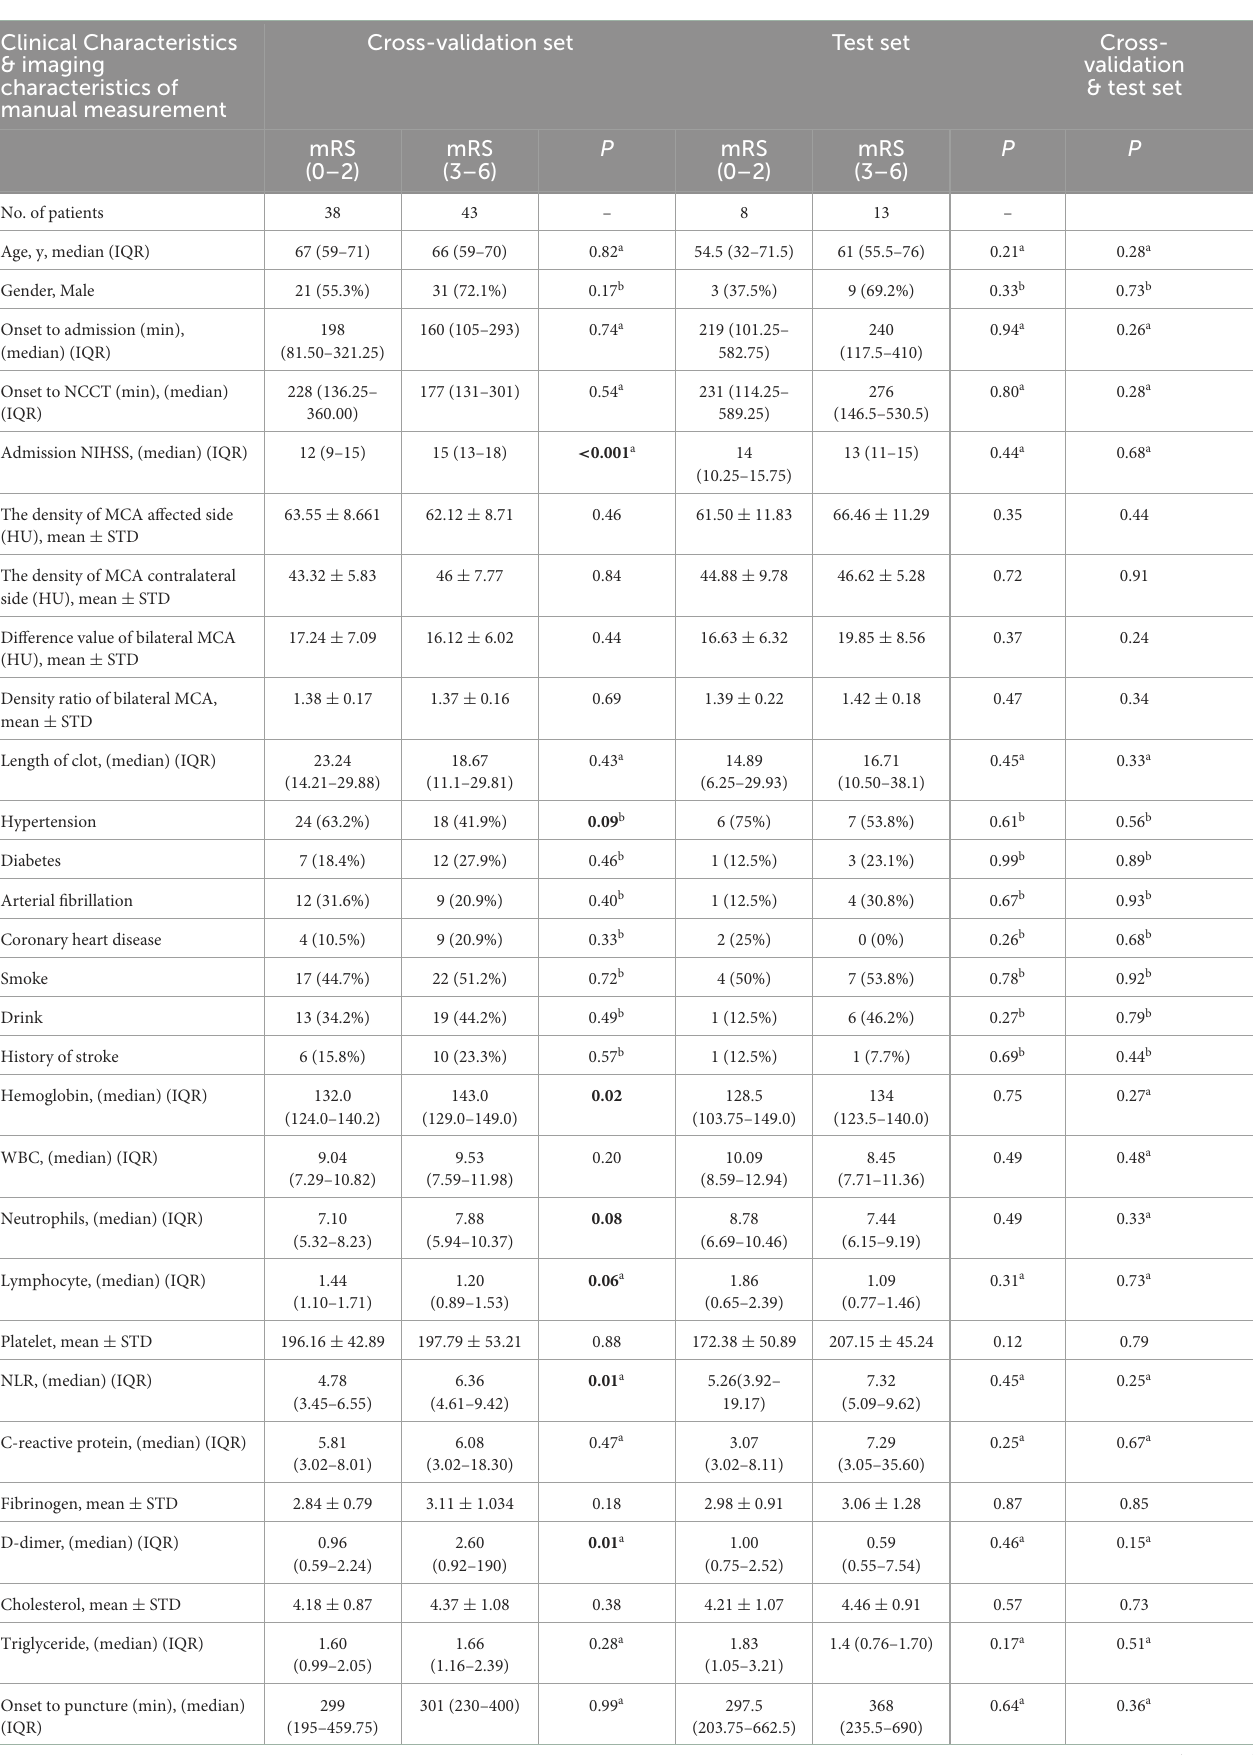
TABLE 1 Correlation analysis of clinical characteristics and 3-month clinical outcome of patients in the cross-validation set and test set. Clinical Characteristics &